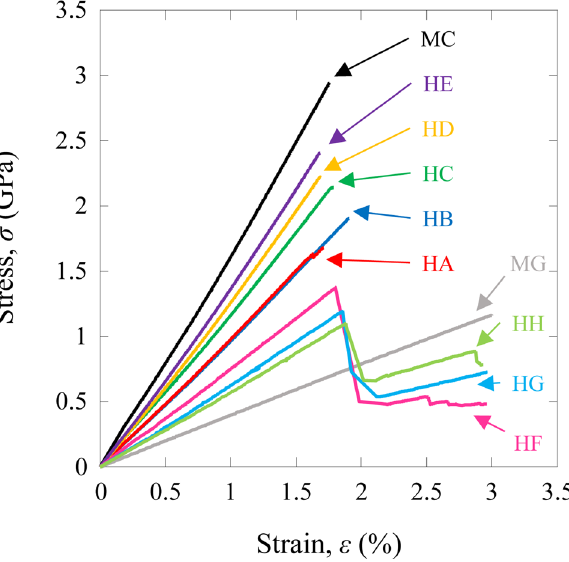
Figure 1. Typical tensile stress–strain curves for the CFRP, GFRP, and HFRP